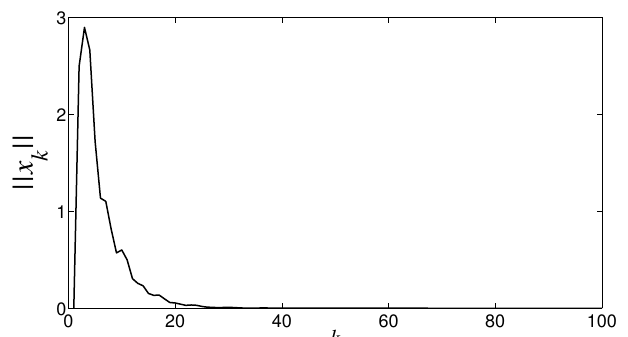
Figure 2. Norm of states for the UPS encountering stealthy DoS jamming attacks when γ = 1.